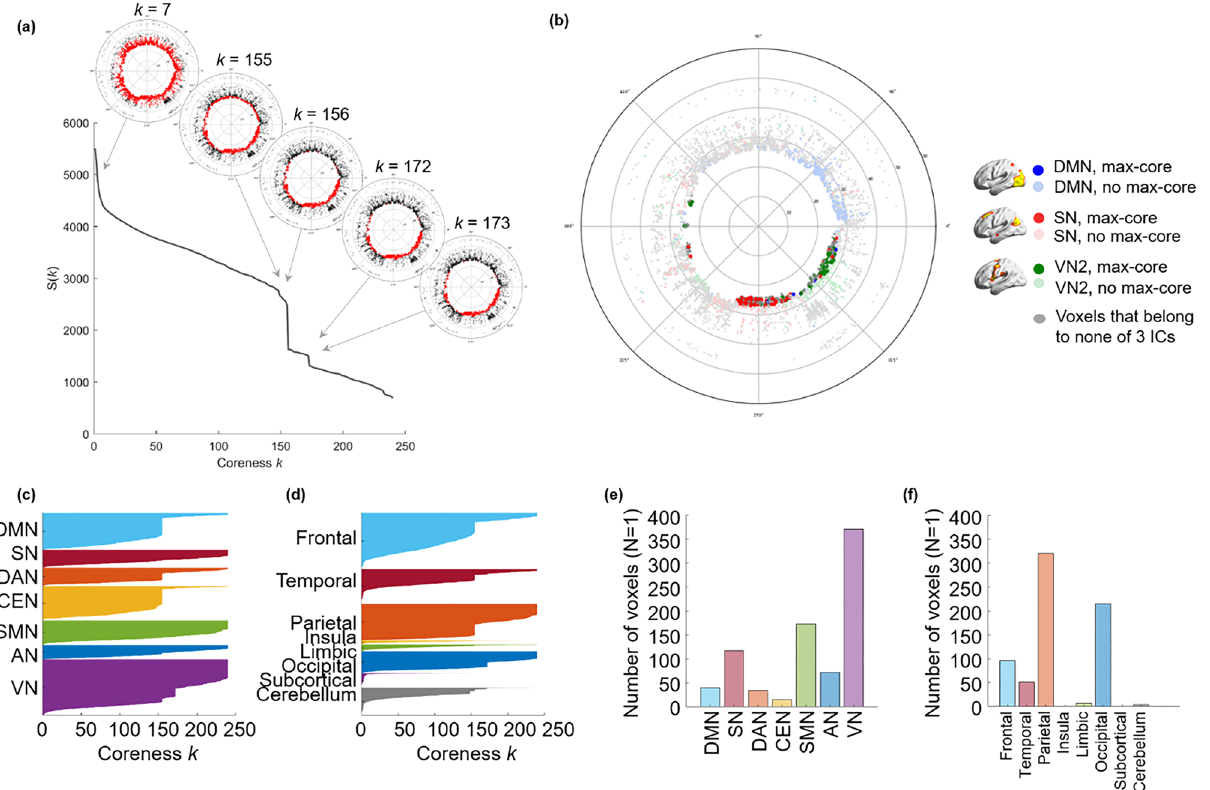
Figure 4. The k -cores and the k max -core depicted by flag plots and hyperbolically embedded discs. Each individual has his/her own size of k max -core and changes in the size of k -cores according to coreness k during k -core percolation. In individuals, a few abrupt decreases were observed over the gradual change of the largest component. ( a ) The coreness k and the size of the core S ( k ) of a subject were plotted, showing two abrupt changes. Specific k -cores that showed an abrupt decline ( k = 7, 155, 156, 172, 173) were embedded on the hyperbolic discs to show the explosive decrease in core voxels. The voxels belonging to a k -core are denoted with red circles; otherwise, they are denoted with black circles on these hyperbolic discs. When the plot shows an abrupt decrease in S ( k ), voxels belonging to the k -core are reduced at once. ( b ) In an individual, k max -core shows the various sizes and independent component (IC)-voxel compositions. The k max -core ( k = 240) of a subject is presented as an example. There were 694 voxels left on the k max -core, and the voxels that belonged to the default mode network (DMN) were in blue, salience network (SN) in red, and visual network 3 (VN3) in green. Voxels other than k max -core voxels are in pale circles. ( c ) The components of each k -core from one subject that vary with coreness k value are shown on the flag plot using functional IC labels ( c ) and anatomical labels ( d ) that annotate voxels to specific subnetworks. In the flag plot, every voxel is presented on the y-axis with labeling, and the horizontal bar of each voxel refers to the maximum k of k -cores to which the voxels belong. The voxels from each subnetwork on the y-axis were sorted in descending order of k . The bar plots show the affiliation of k max - core voxels ( e,f ). This individual showed abrupt declines in k -core size in the DMN, dorsal attention network (DAN), central executive network (CEN), and VN by functional labels and in the frontal, temporal, parietal, and occipital lobes by anatomical labels. The k max -core voxel was classified using larger functional labels (7 ICs) ( e ) and anatomical labels (8 lobes) ( f ). In this individual, VN or parietal/occipital lobe voxels belonged in the largest number to the k max